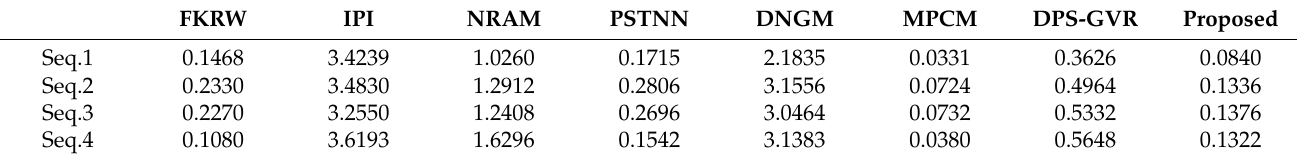
Table 5. Average running time (s) of different